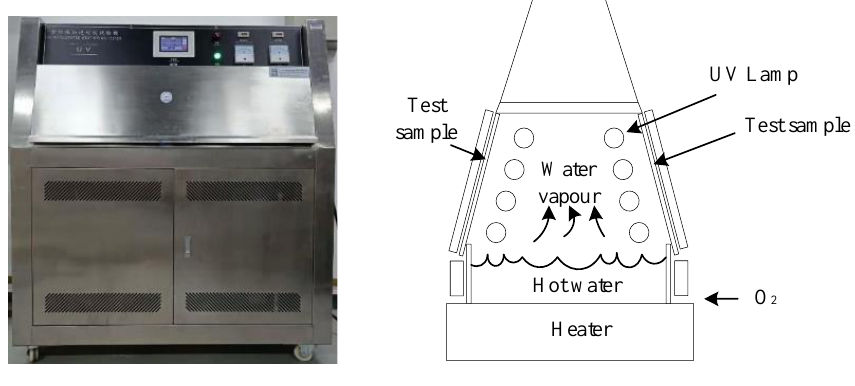
Figure 2. The UV aging test chamber.